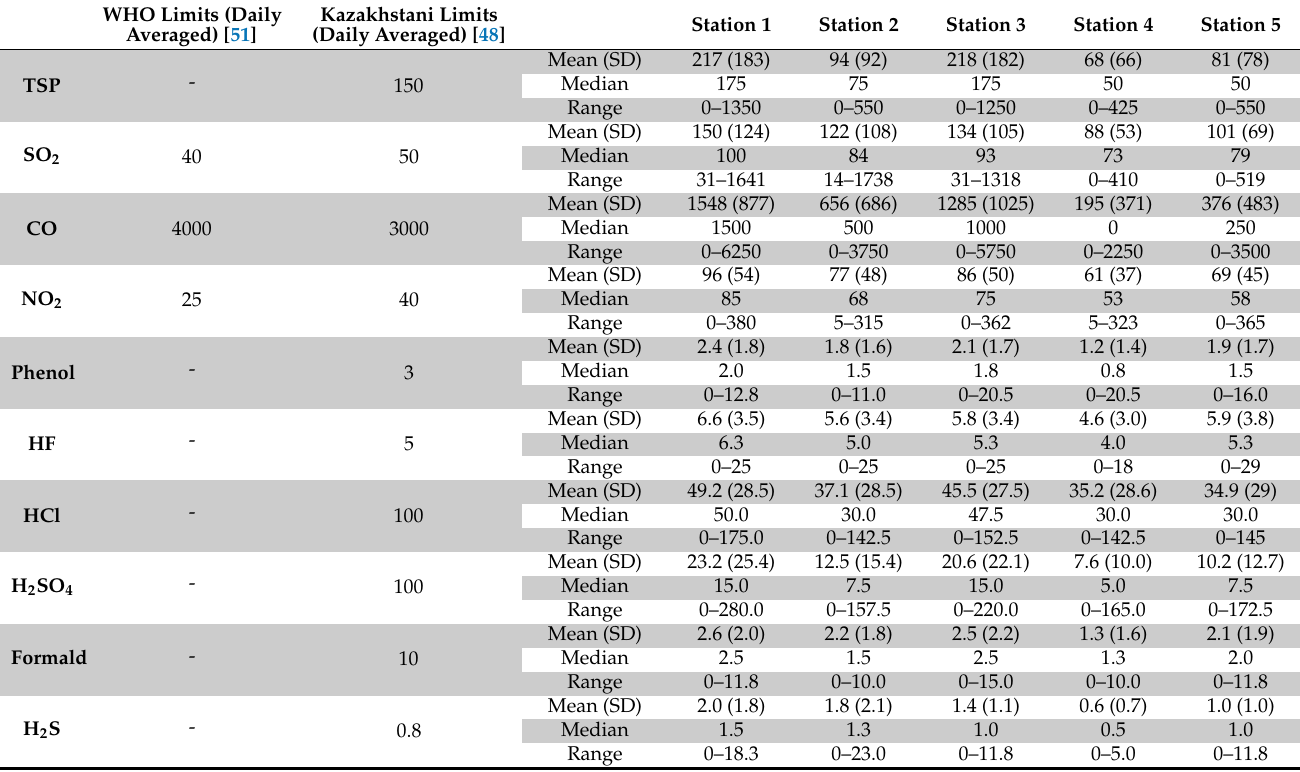
Table 2. Descriptive statistics of air quality during the cold seasons (in µ g m − 3 ).